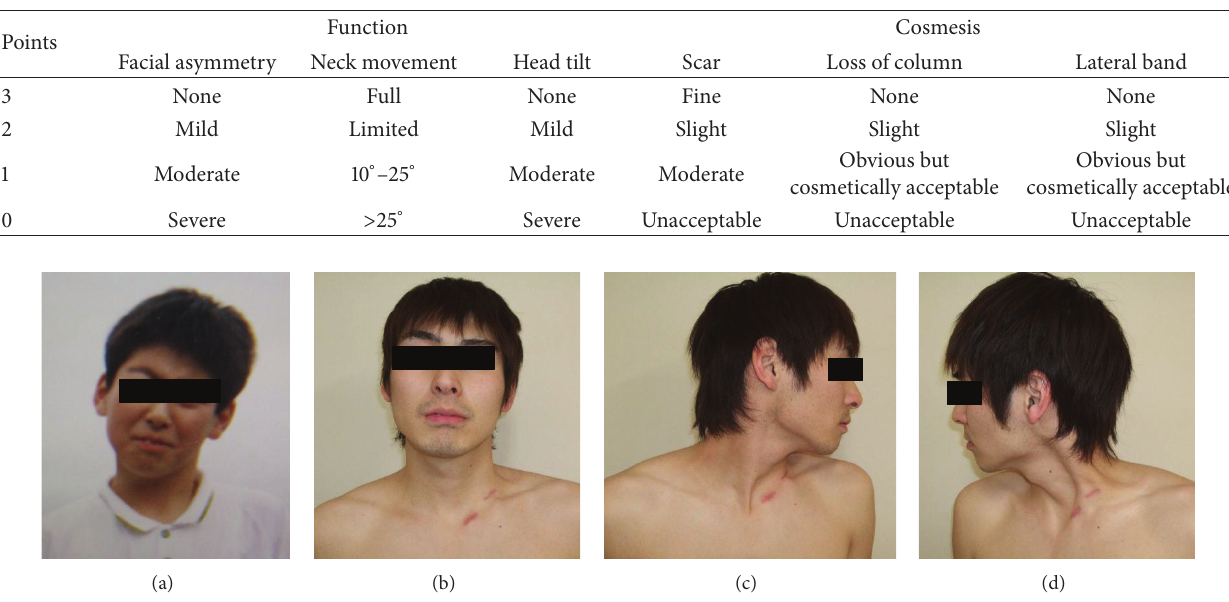
Table 1: Scoring system for assessment of muscular torticollis (modified from [7]).